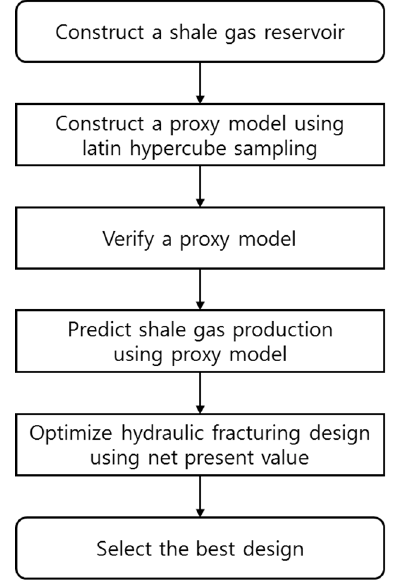
Figure 1. Flow diagram developed for this work.